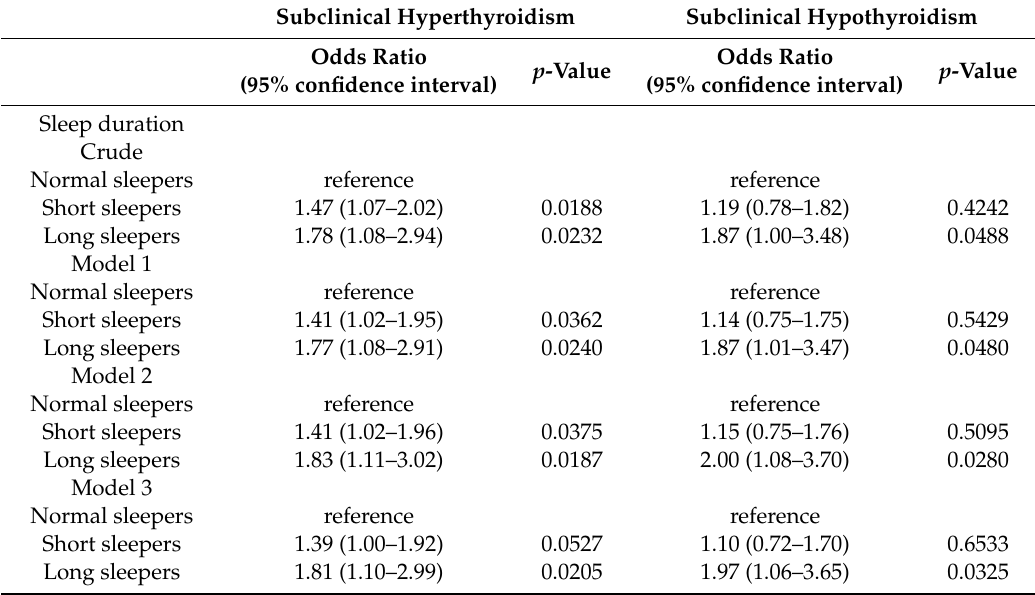
Table 4. Risk of subclinical thyroid dysfunctions according to sleep duration in subjects with anti-TPO antibody less than 34 IU /